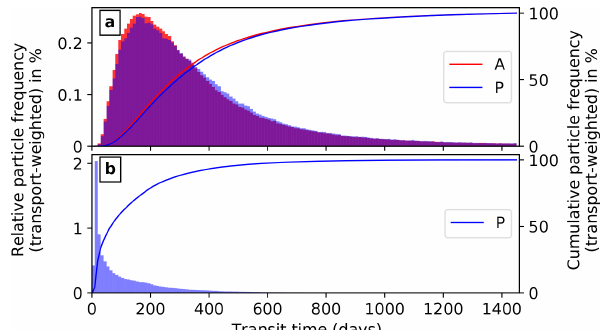
Figure 3. Mean (1958–2014) transit time distribution (transport- weighted) of Agulhas leakage from the Agulhas Current at 32 ◦ S to (a) the Good Hope section and (b) 20 ◦ E for experiment A in red and P in blue, overlapping probabilities are shown in purple. The transit time to 20 ◦ E can not be analysed in experiment A because it was run in the quantitative mode of